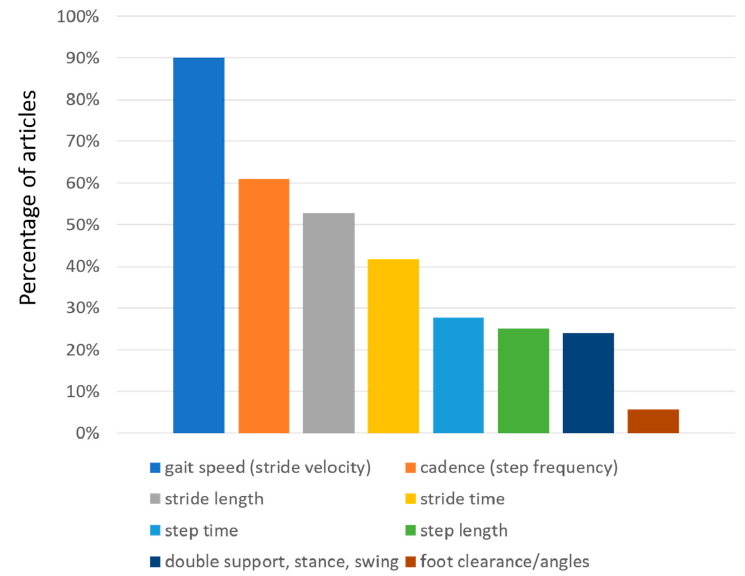
Figure 4. Distribution of gait spatio-temporal parameters evaluated in the selected articles. The percentage of the articles that report each parameter is presented.